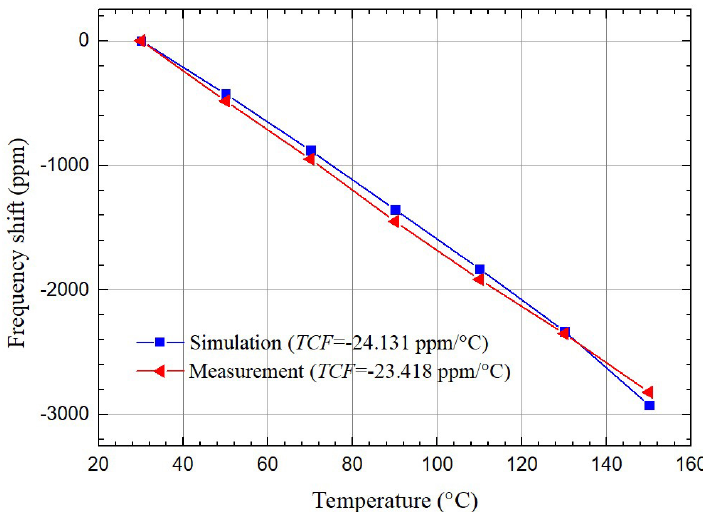
Figure 9. Measured and simulated TCF s of the QSAW resonator with λ of 10.4 µ m in a temperature range from 30 ◦ C to 150 ◦